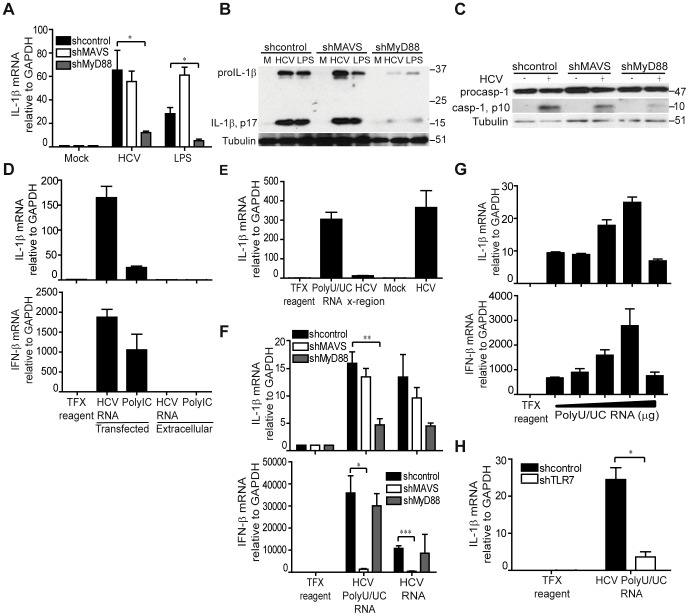
HCV stimulation of IL-1β expression occurs through MyD88-dependent viral RNA signaling by TLR7.(A) THP1 cells stably expressing non-targeting shRNA (control) or shRNA specific to MAVS or MyD88 were mock treated with media alone, exposed to HCV (moi = 0.01) or treated with LPS (1 µg/ml) and IL-1β expression assessed by qRT-PCR, *P = 0.0341and *P = 0.013. (B) Immunoblot analysis of IL-1β in THP-1 stably expressing the indicated shRNA. Cells were exposed to media alone (M) or infectious HCV supernatant for 6 hr. (C) Immunoblot of caspase-1 in THP-1 stably expressing the indicated shRNA. (D) IL-1β (upper panel) and IFN-β (lower panel) mRNA expression in THP-1 post-treatment with transfection reagent alone (control) or transfected with full length HCV RNA or poly IC (transfected); or treated with media containing full length HCV RNA or poly IC (extracellular). (E) IL-1β mRNA levels in THP-1 transfected with HCV polyU/UC RNA (1 µg/ml), HCV X-region (1 µg/ml) or exposed to infectious HCV for 6 hrs. (F) IL-1β (upper panel) and IFN-β (lower panel) mRNA expression in THP1 harboring the indicated shRNA, *P = 0. 0115, **P = 0.0094 and ***P = 0.0009. (G) IL-1β (upper panel) and IFN-β (lower panel) mRNA expression in THP-1 cells transfected with increasing doses (0.125, 0.25, 0.5, 1 and 2 µg/ml) of HCV polyU/UC RNA. (H) IL-1β mRNA expression in THP1 cells stably expressing non-targeting or shRNA specific to TLR7, *P = 0.022, by student's t-test.